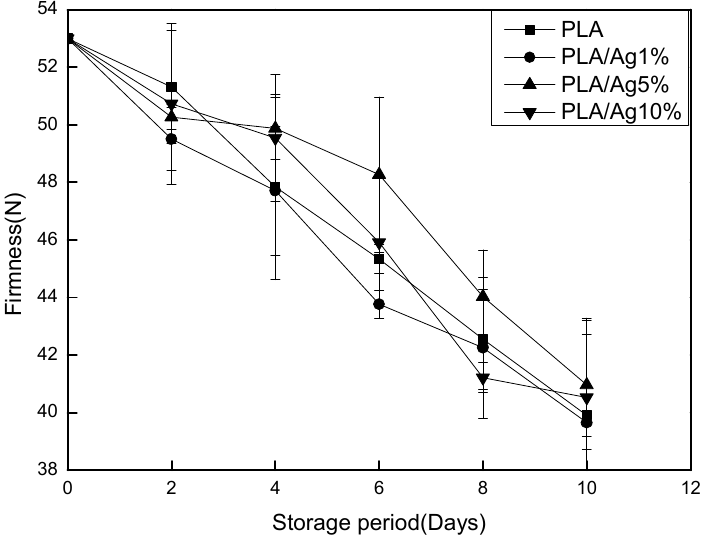
Figure 2. Effect of different concentration of nano-Ag active packages on firmness of strawberry stored at 4 ± 1 °C for 10 days. Data are presented as mean ± standard deviation.